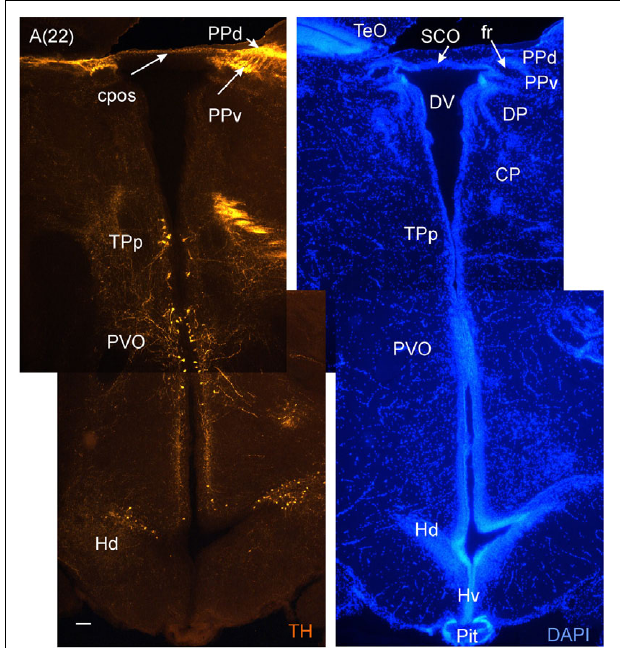
FIGURE 6 | A consecutive more caudal transverse section of the archerfish diencephalon (A) immunostained for tyrosine hydroxylase (TH) with accompanying nuclear (DAPI) counterstain showing pretectal (PPd/PPv), posterior tubercular (TPp, PVO) and hypothalamic (Hd) dopamine cells. Arabic numerals in brackets indicate the relative distance of sections. Scale bar in (A): 0.1 mm. See abbreviation list and text for